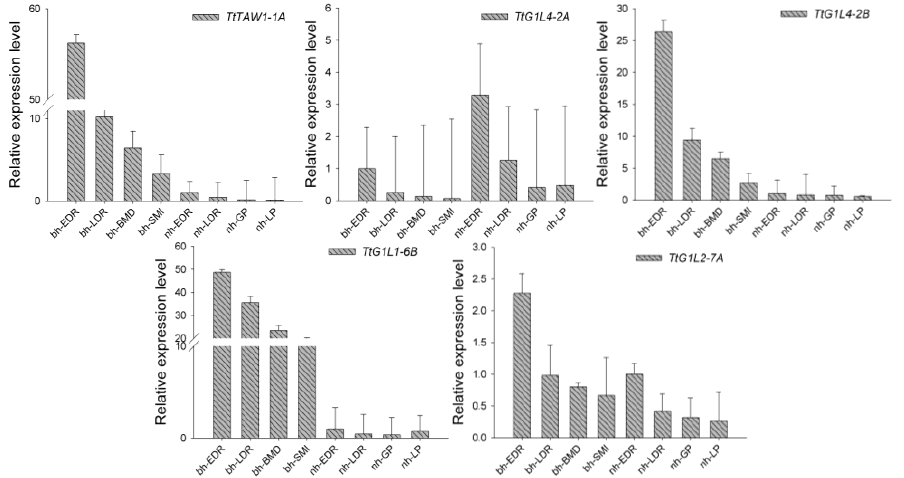
Figure 4. Relative abundance of some ALOG homolog mRNAs as determined by quantitative real-time polymerase chain reaction (qRT-PCR) with samples from the spikes of GAN-A631 (bh) and GAN-A1582 (nh) at the early developmental stages of the spike. The values shown correspond to the mean values for three biological and three technical replicates. Spike developmental stages were assigned as follows, EDR, early double ridge stage; LDR, late double ridge stage; BMD, branch meristem development stage; SMI, spikelet meristem-initiated stage; GP, glume primordia stage; and LP, lemma primordia stage. The use of the bh and nh prefixes means that the samples came from GAN-A631 (bh) and GAN-A1582 (nh), respectively.